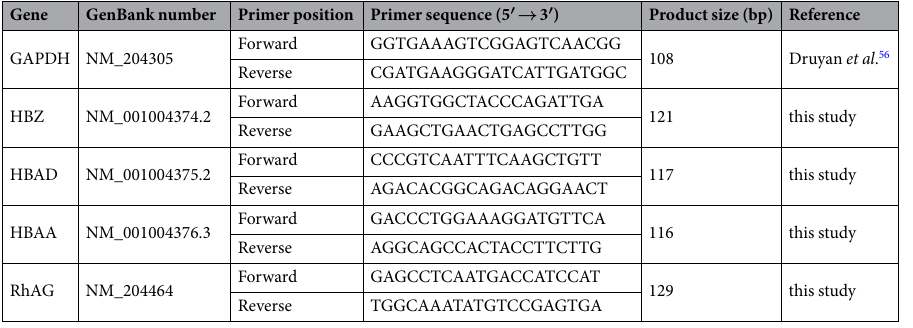
Table 4. Primer sequences for the target